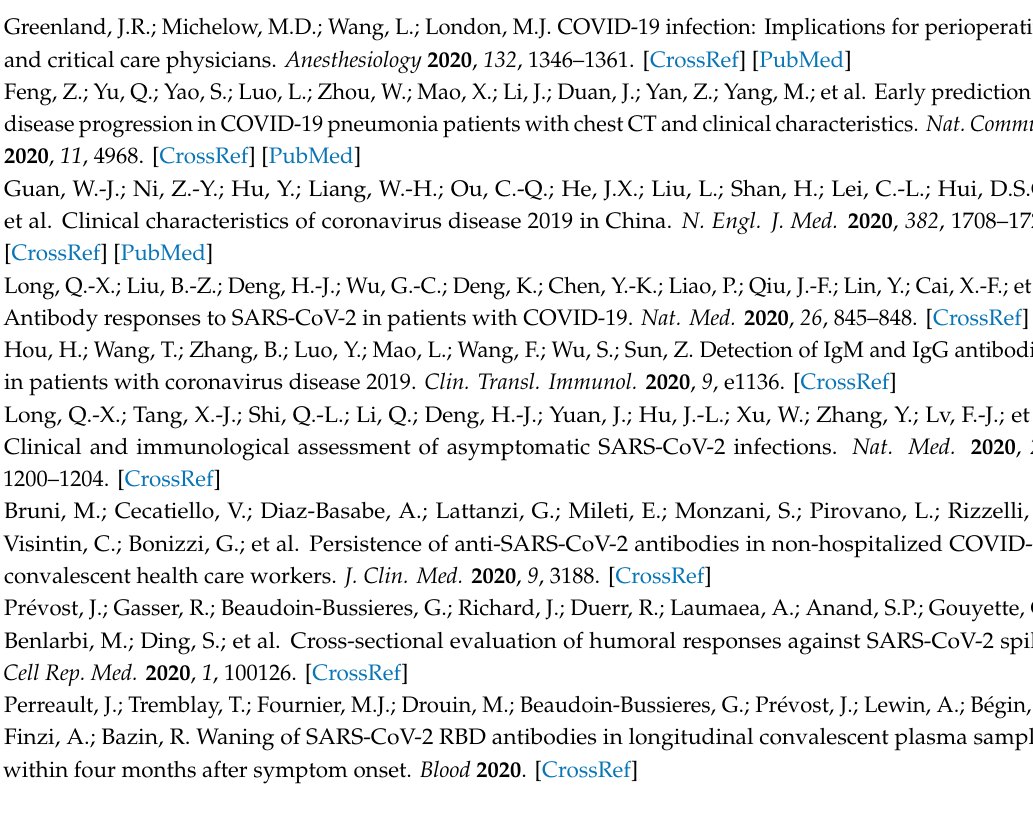
Figure S1: Detection of anti-SARS-CoV-2 antibodies in one ICU and one non-ICU patient, over time, using a commercial and an in-house cell-based ELISA, Figure S2: Western blot of mock-infected Vero E6 cells (-) and SARS-CoV-2 infected cells ( + ) using plasmas of one ICU and one non-ICU hospitalized patient, Table S1: Baseline characteristics of symptomatic COVID-19 ICU and non-ICU patients hospitalized at CHU of La R é union, Table S2: Laboratory findings of symptomatic COVID-19 ICU and non-ICU patients hospitalized at CHU of La R é